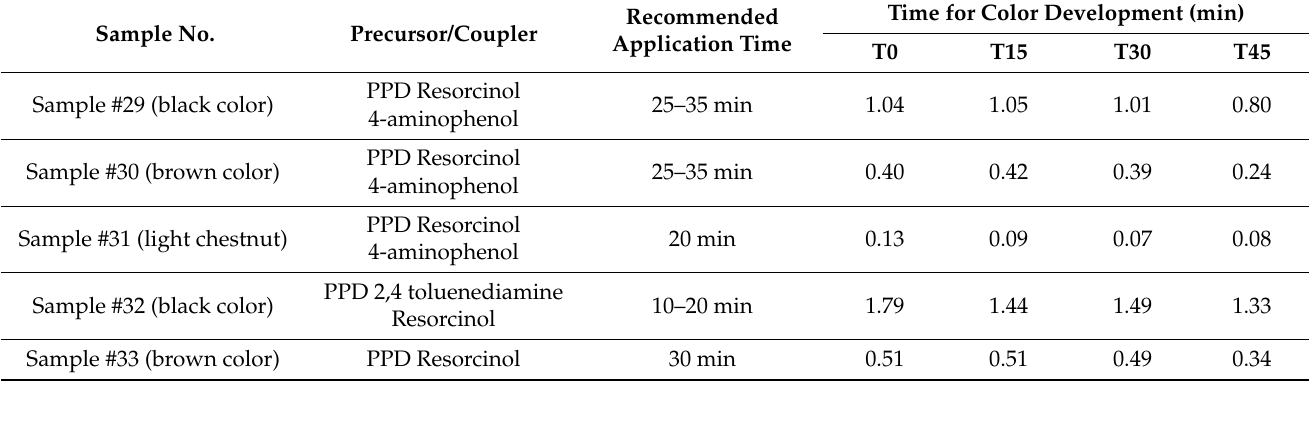
Table 7. Contents of unreacted PPD % w / w in oxidative hair dye formulations.